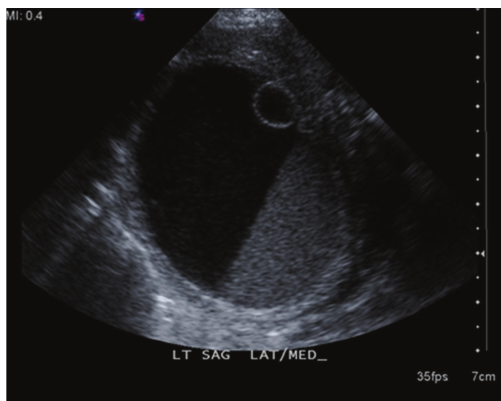
Figure 1: A sagittal gray scale image of the left ovary shows a 4.5 × 5.6 × 4.5cm cystic mass with low-level-dependent echoes, consis- tent with internal hemorrhage. A smaller cyst is seen internally, measuring 1.0cm in diameter. The findings were identical when compared to the prenatal ultrasound. Similar findings were seen on the parental ultrasound.